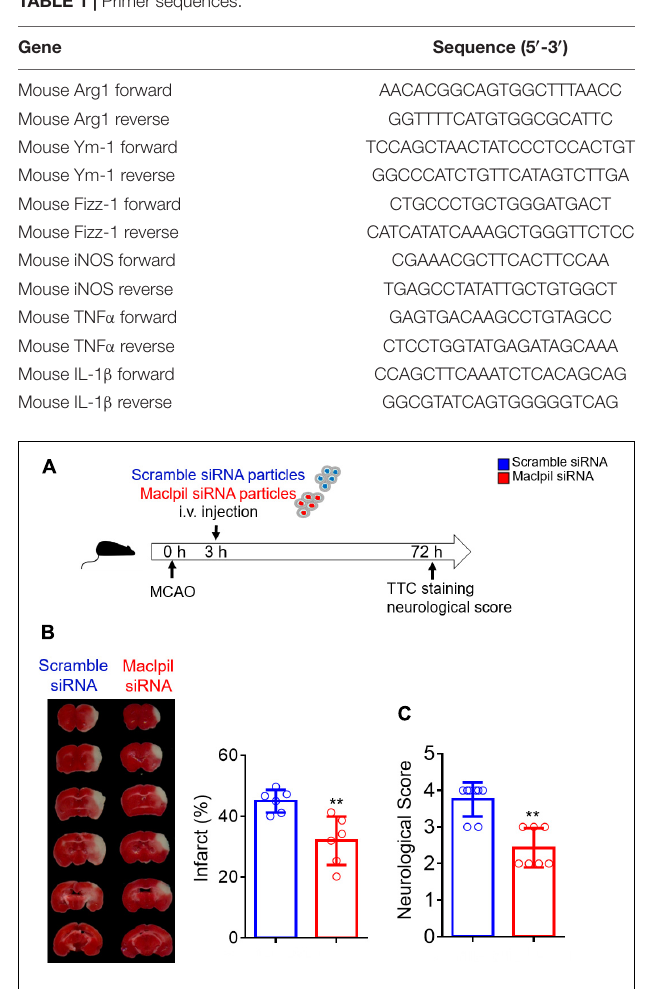
FIGURE 1 | siRNA silencing Maclpil reduces ischemic infraction size and improves neurological behaviors. (A) Three hours after MACO surgery, mice were intravenously injected with nanoparticle conjugated Maclpil or scramble siRNA. Neurological behaviors and infarction size were assessed 3 days after the MCAO surgery. (B) Images for infarction area identified by TTC staining and quantification of infarction size. (C) Quantification of neurological score. All data are mean and SD from 6 (B) and 7–8 (C) mice in each group. Student’s t -test, ** p < 0.01 compared to scramble siRNA